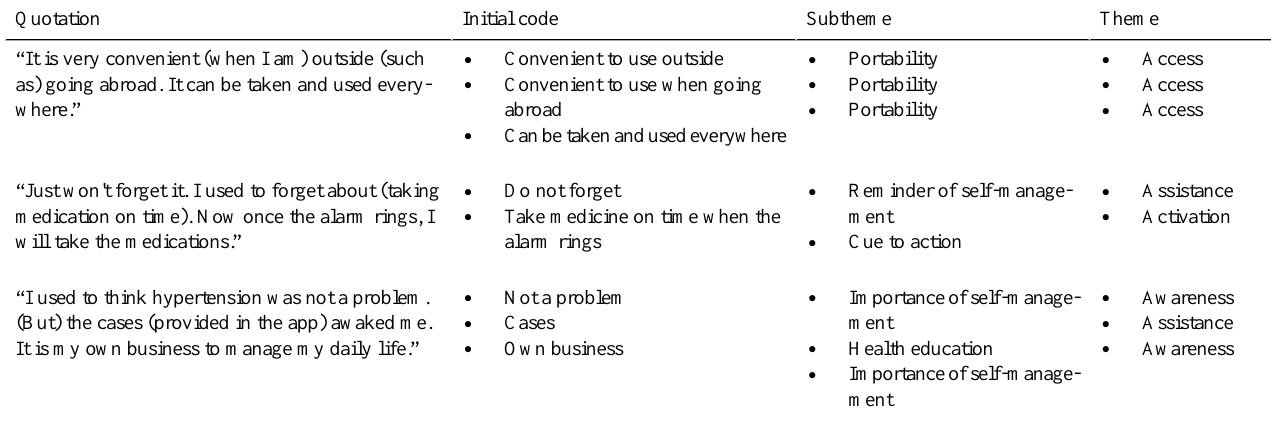
Table 1. Examples of initial codes, subthemes, and themes from the